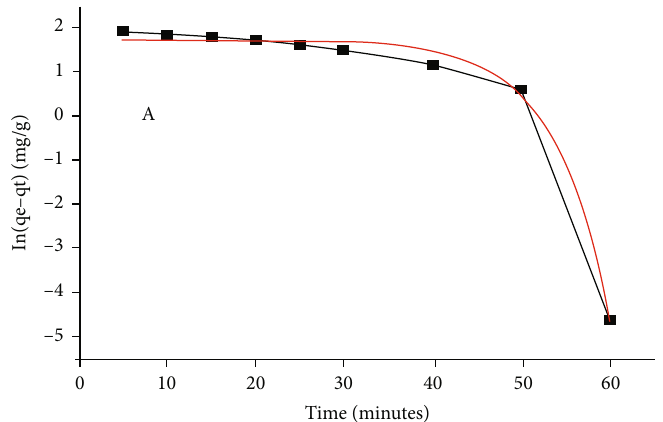
Figure 11: Nonlinear fi tting of PFO kinetic for Cr(VI) ion adsorption from aqueous